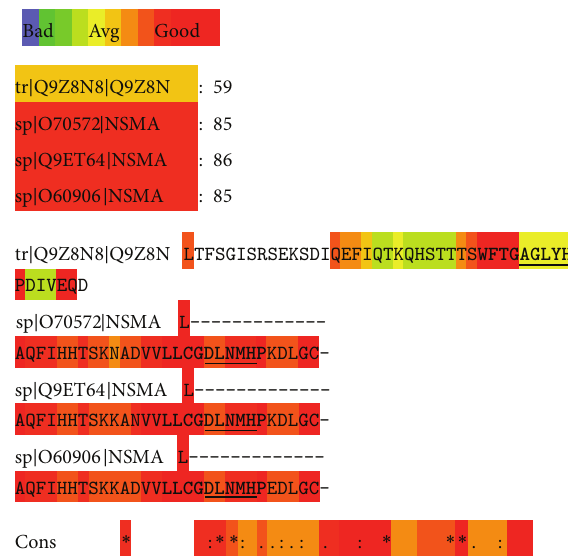
Figure 2: T-coffee alignment of CPn0300 (top) with the sequences involved in proton binding and substrate recognition by type 1 neu- tral SMases sp | O70572 | NSMA ( Mus musculus ), sp | Q9ET64 | NSMA ( Rattus norvegicus ), and sp | O60906 | NSMA ( Homo sapiens ) as indicated.